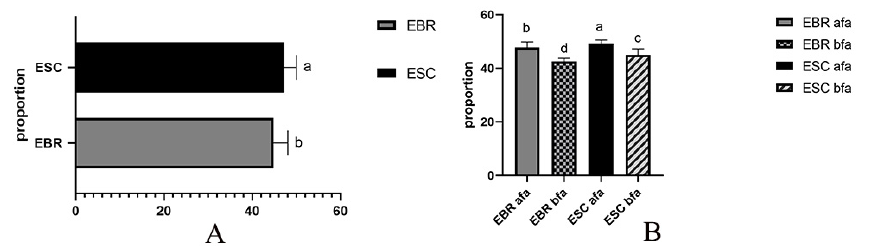
Figure 7. Comparison of rostral cuticle thickness in Eucryptorrhynchus scrobiculatus (ESC) females and